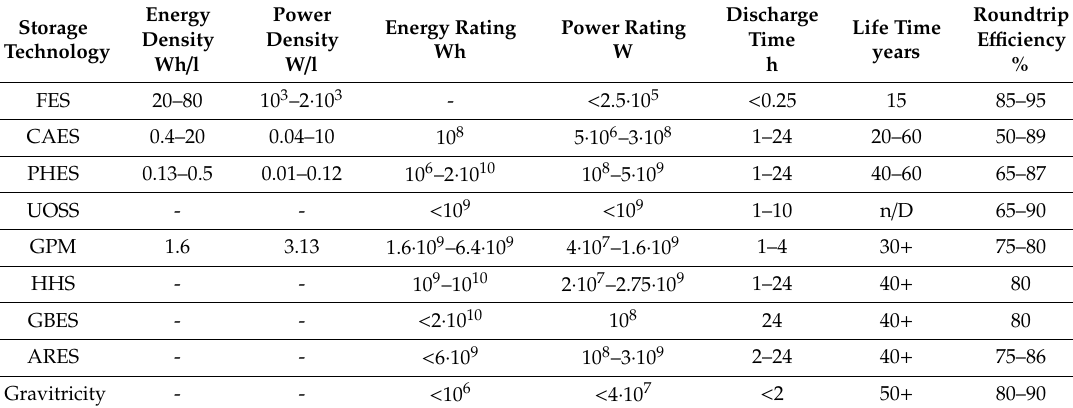
Table 1. Technologies of energy storage and systems characteristics. Adapted from